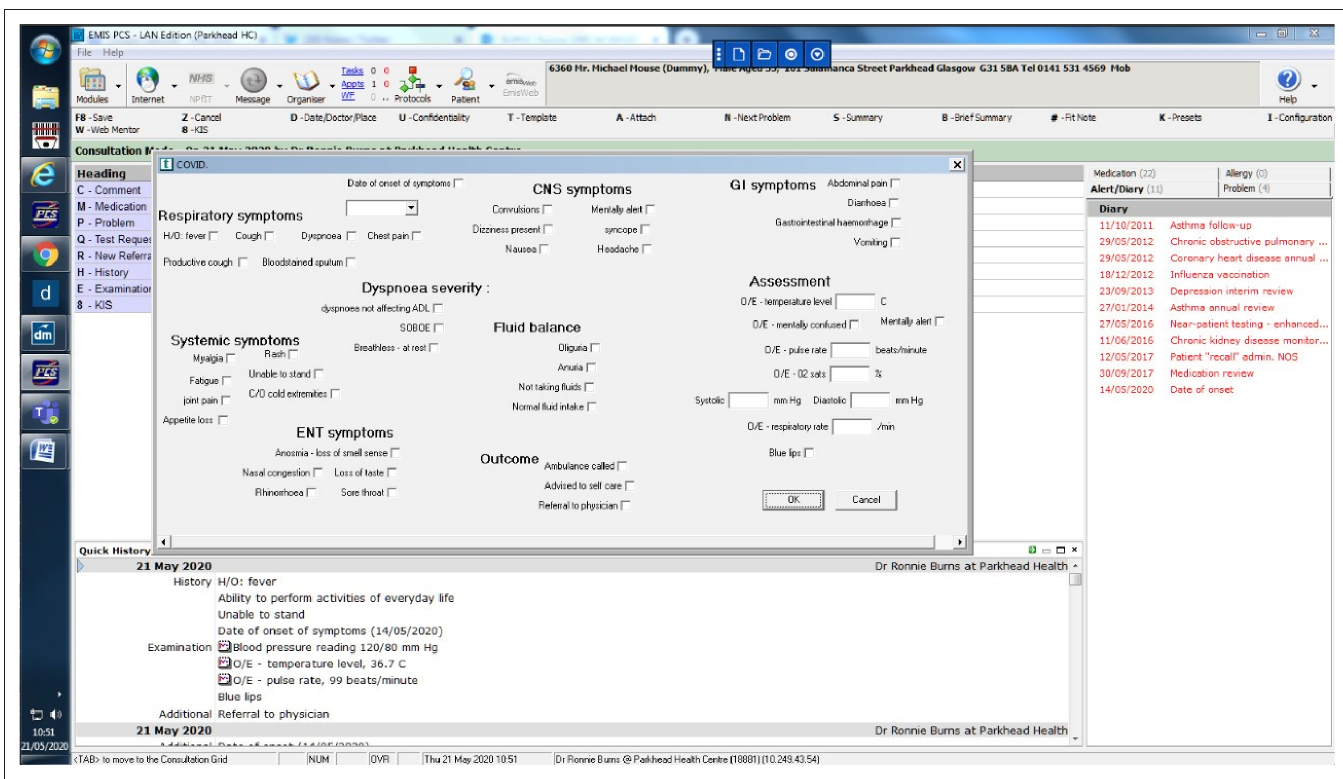
Figure 1 A consultation template prototype in EMIS with symptoms and assessment items for recording COVID-19 consultations in primary